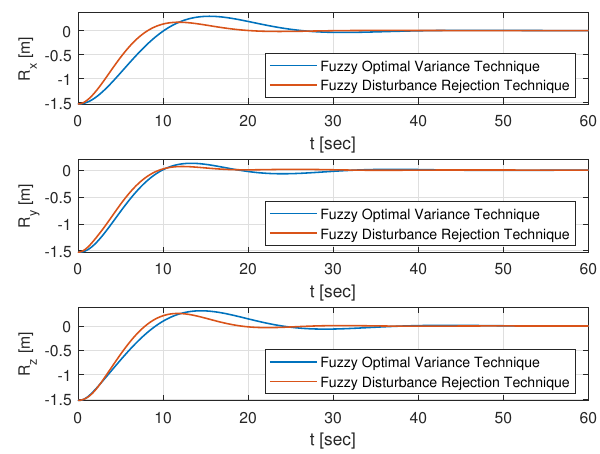
Figure 23. Position of the center of mass of the spacecraft.